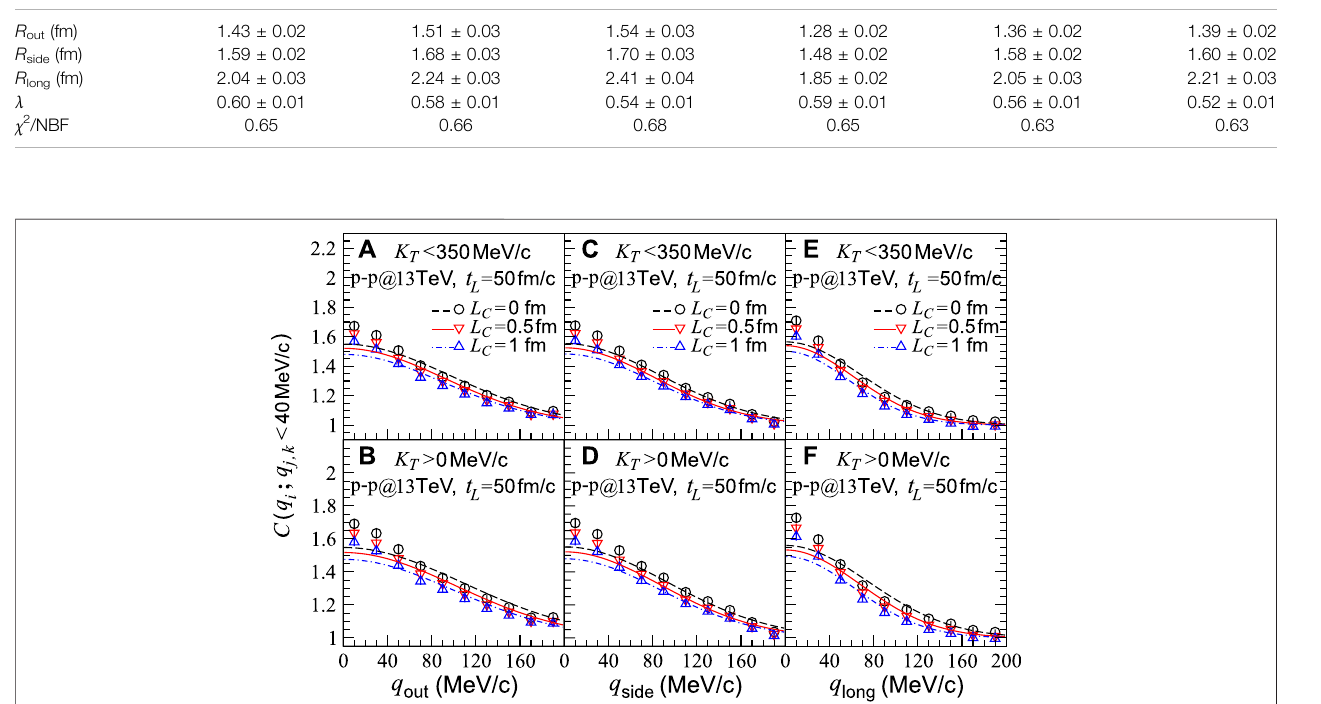
(cid:1) √ (cid:3) 13 TeV and s